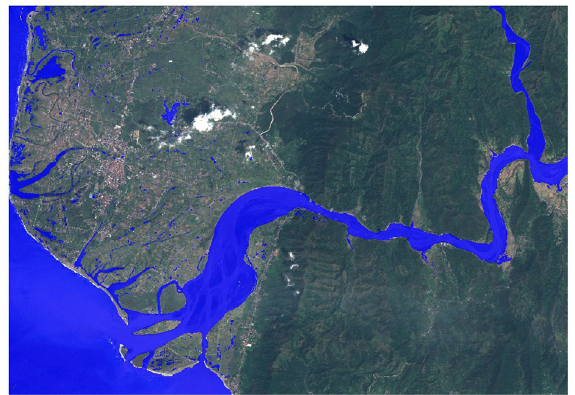
Figure 1. An example of a data product from the Copernicus EMS catalogue (activation EMSR312), in this case a map showing flood extent over the city of Vigan in the North West of Luzon island in the Philippines in September 2018. A blue water mask (here generated using an automatic method from a RADARSAT-2 image) is overlaid on top of a Sentinel-2 image, showing the extent of flooding. Sentinel 2 imagery and Copernicus